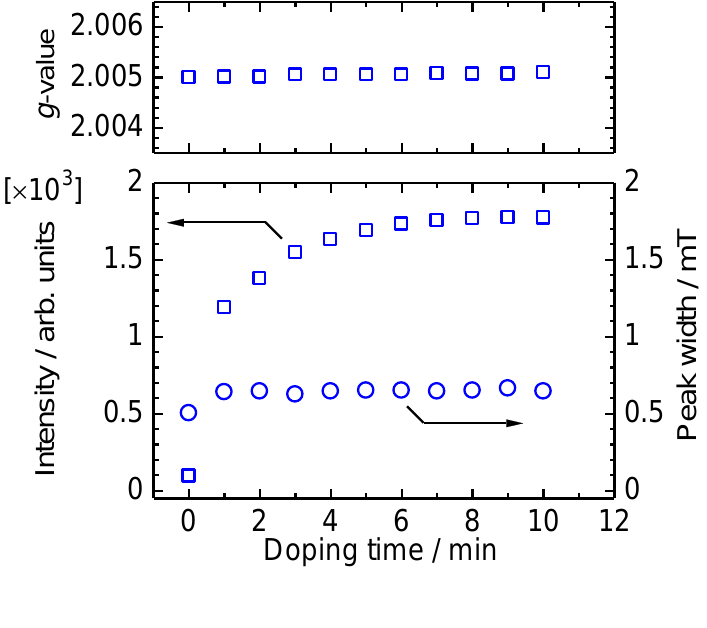
Figure 8. g -value, intensity, and peak width (  H doping for 0–10